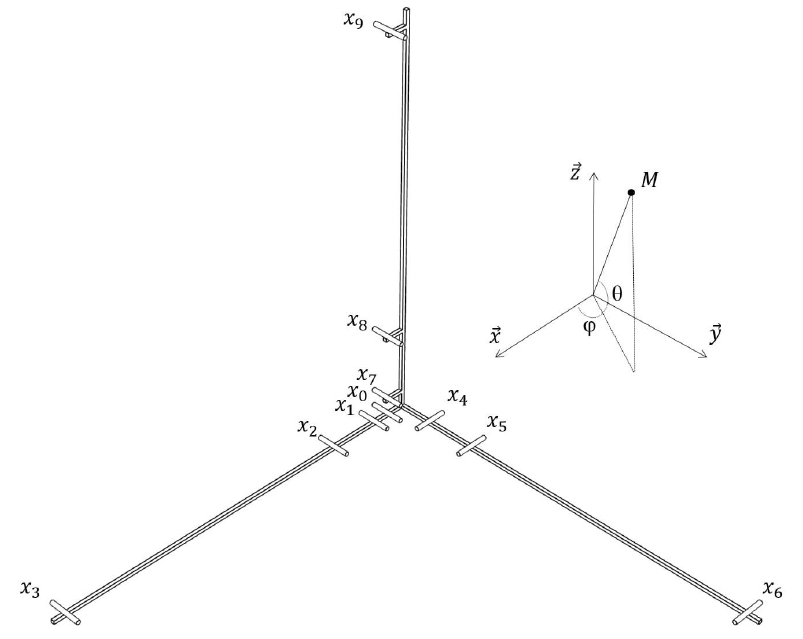
Figure 1. Coordinate system and microphone array used to localize the drone at